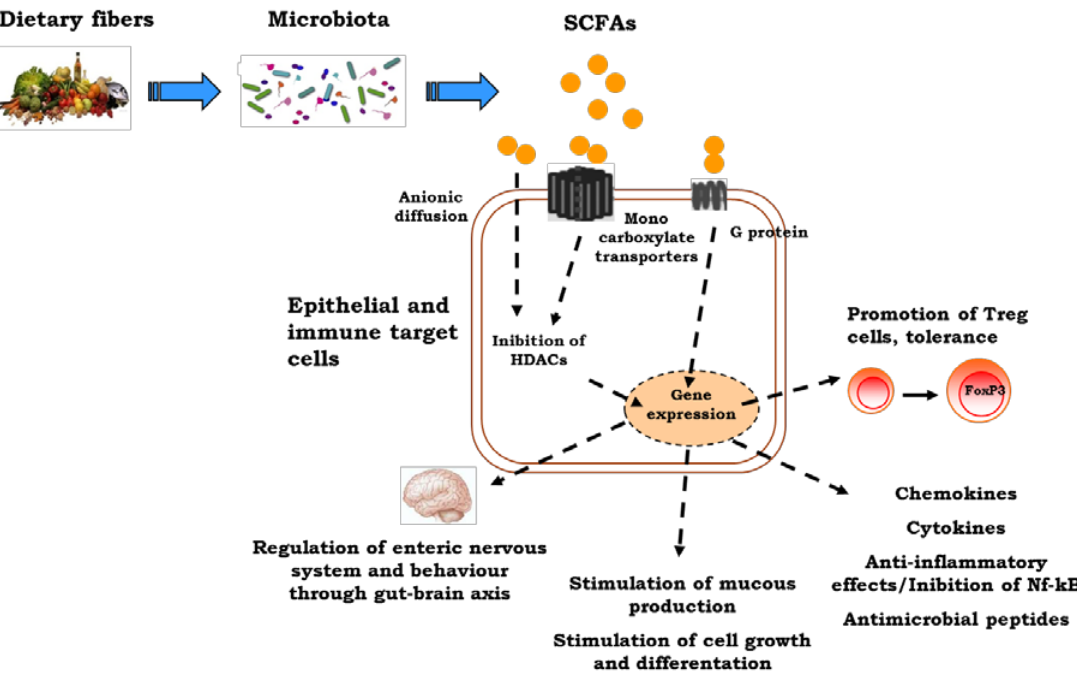
Figure 1. The influences of early nutrition on the immune system. Dietary factors may induce direct epigenetic modifications and/or may influence epigenetic mechanisms through a modulation of gut microbiota composition and function. The short-chain fatty acid, butyrate, produced by gut microbiota exerts a broad range of epigenetic effects influencing immune system development and function. SCFAs, short-chain fatty